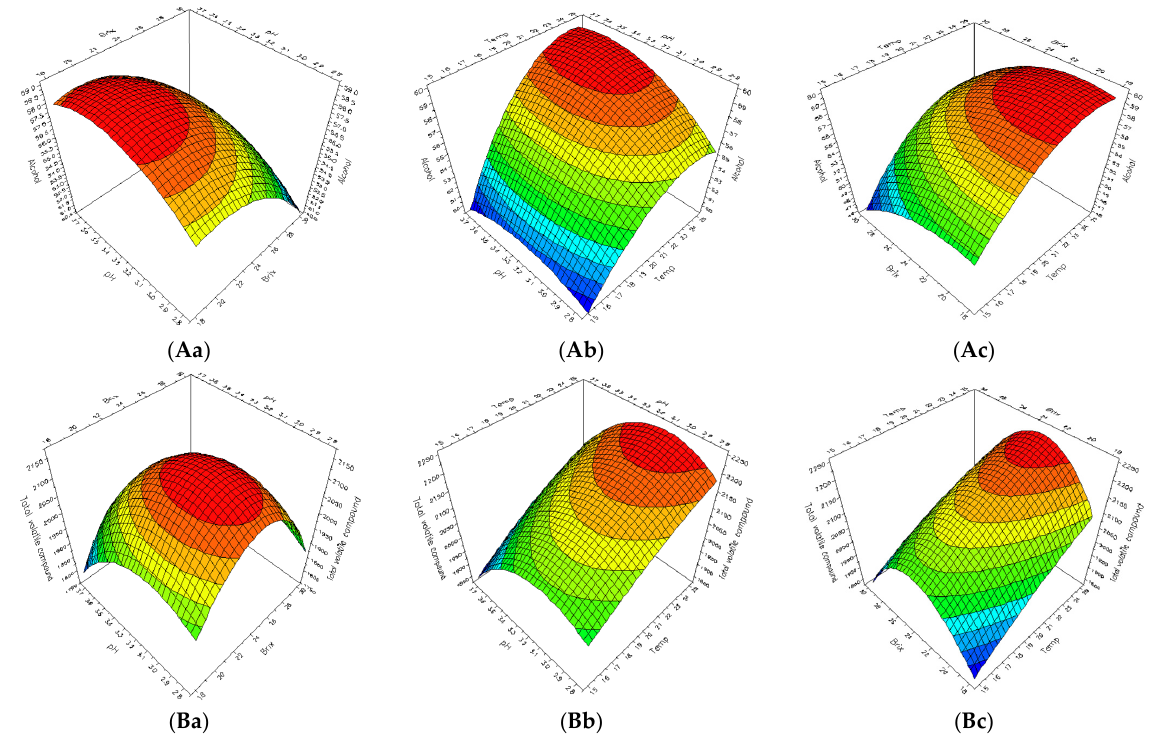
Figure 1. Response surface ( a ) pH vs. Brix, ( b ) pH vs. temperature, and ( c ) Brix vs. temperature on the production yields of alcohol ( A ) and volatile compounds ( B ) from the fermentation of cherry juice.